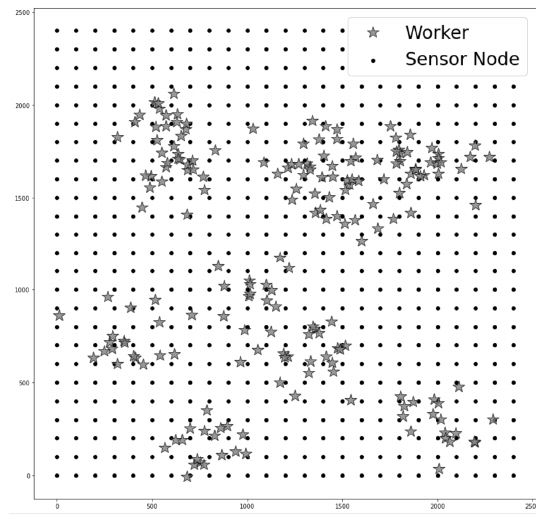
Figure 8. An example of industrial site